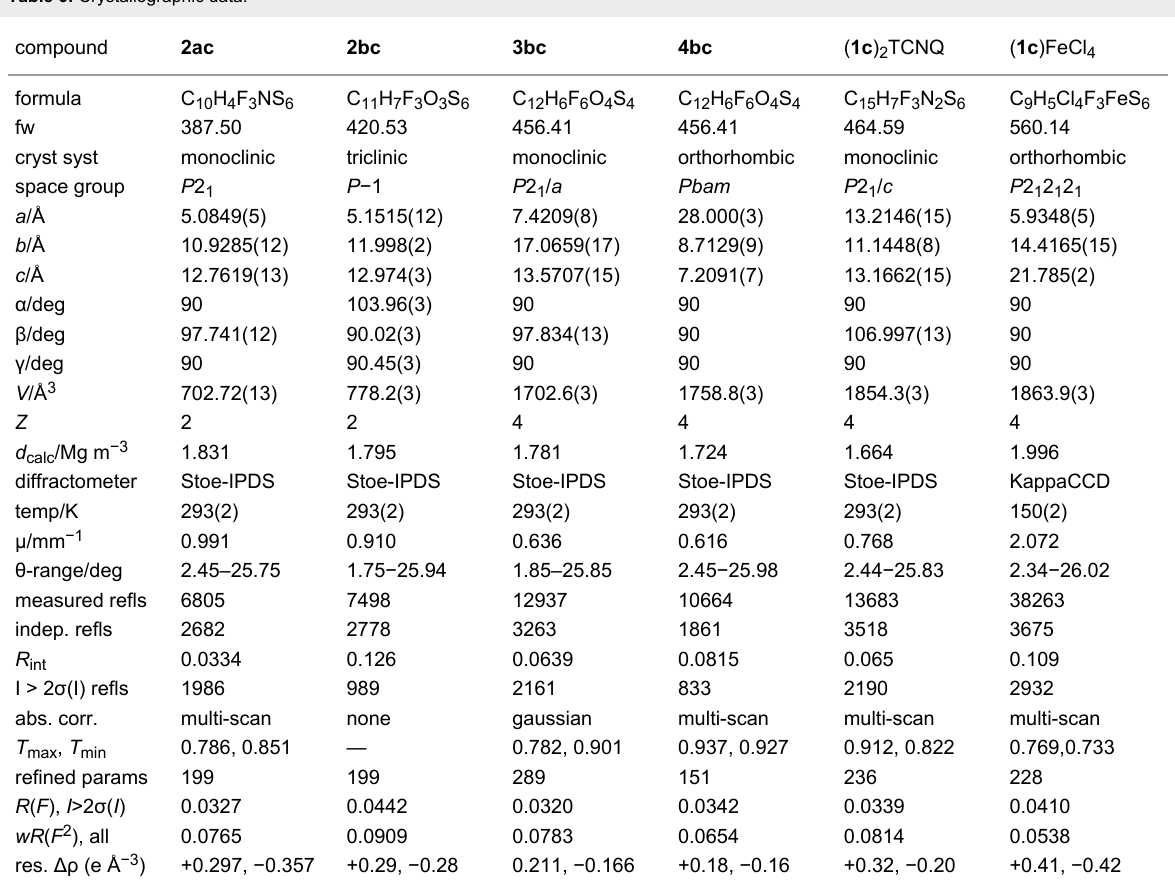
Table 6: Crystallographic